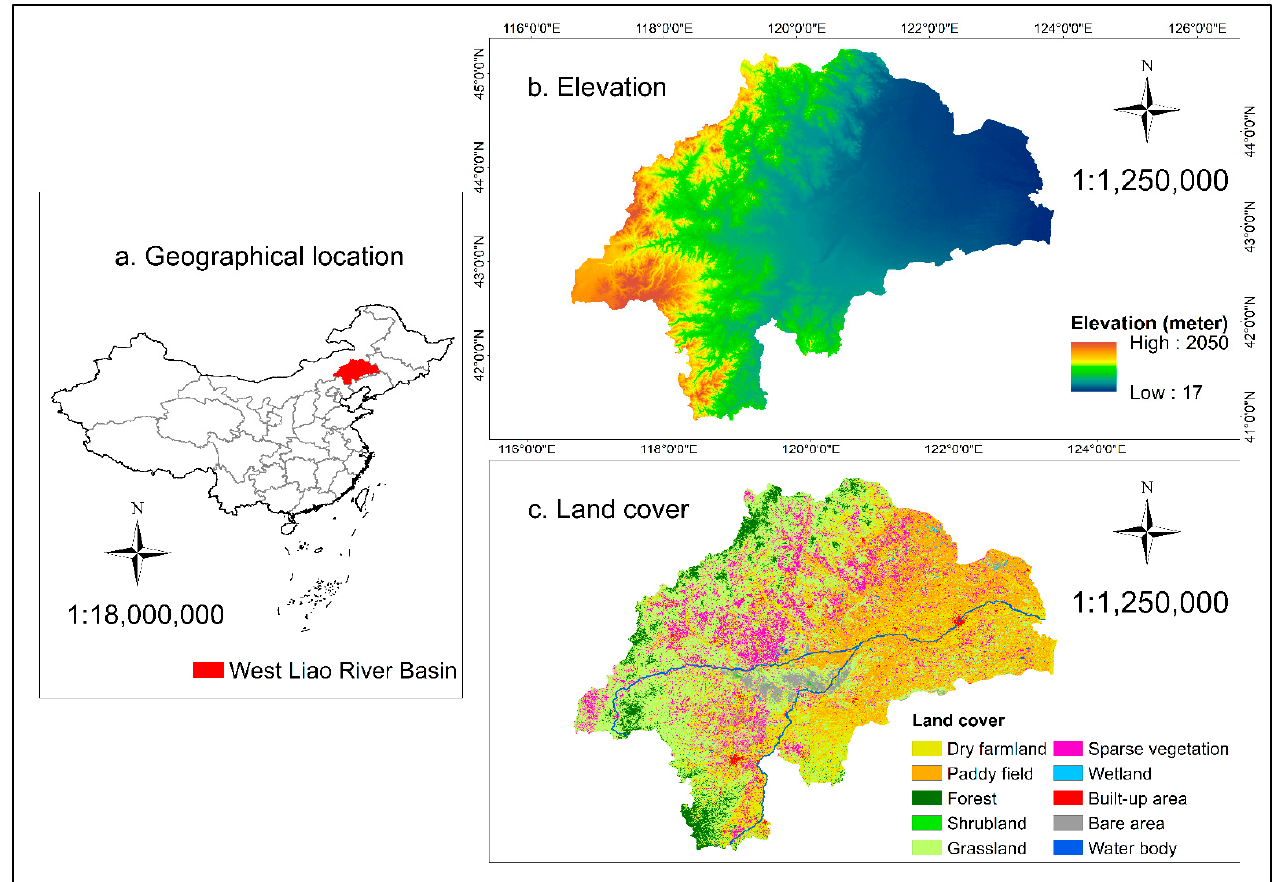
Figure 1. ( a ) Geographical location, ( b ) Elevation, and ( c ) Land cover of the West Liao River Basin.